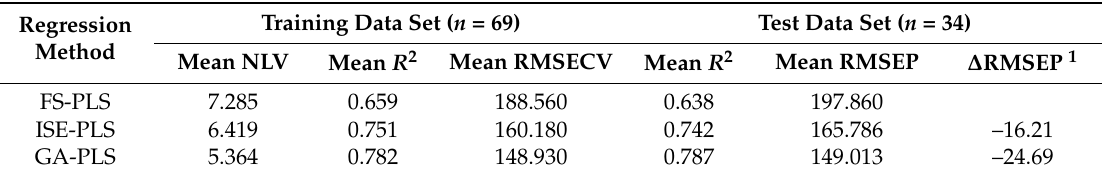
Table 5. Mean values of NLV, R 2 and RMSECV/RMSEP from N = 10,000 evaluations using independent training and test data sets with FS-PLS, ISE-PLS and GA-PLS.